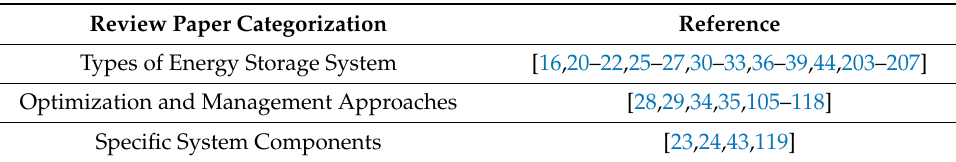
Table 9. References of the most recent review papers on